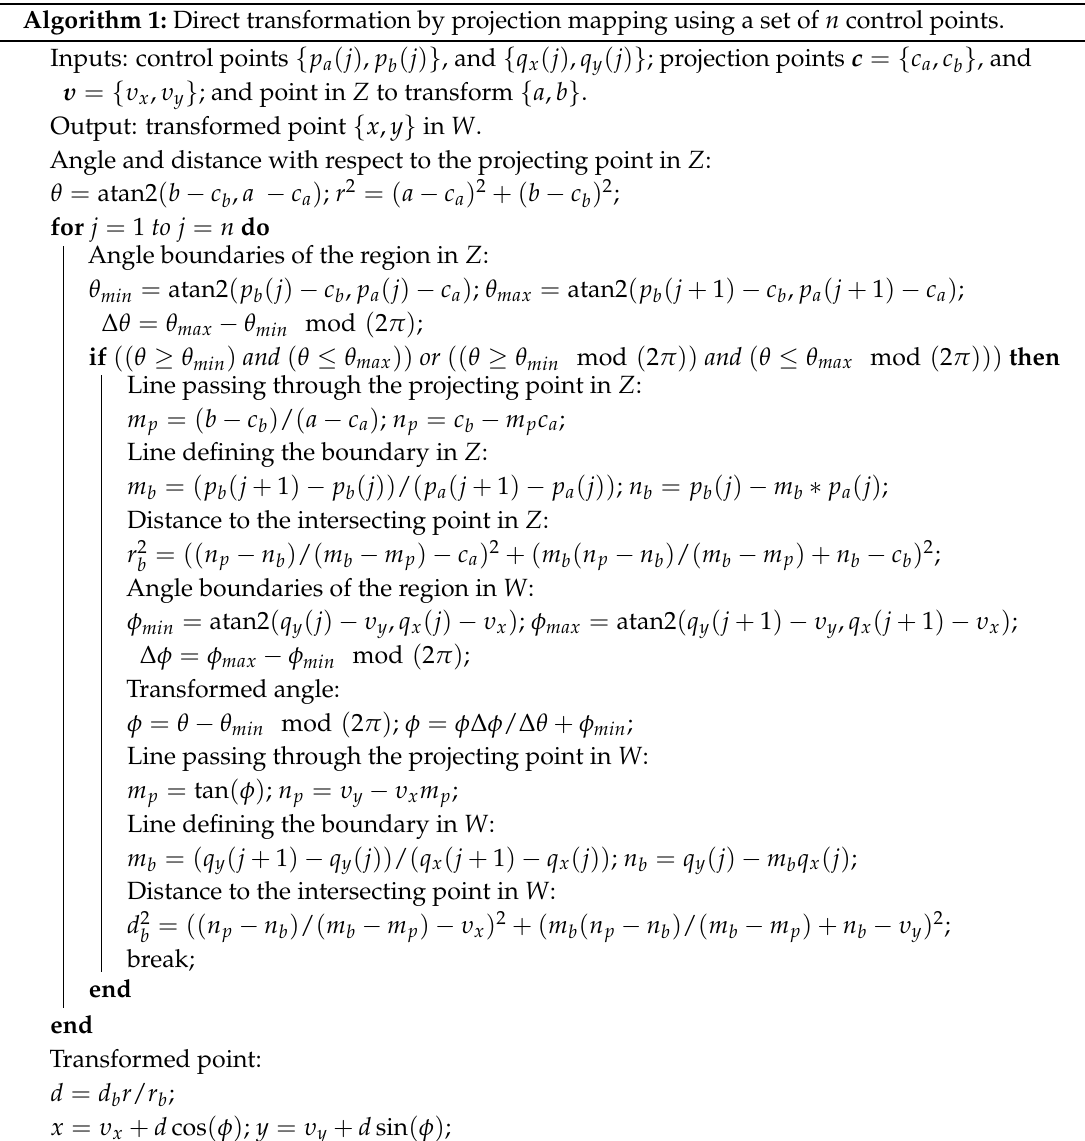
Algorithm 1: Direct transformation by projection mapping using a set of n control